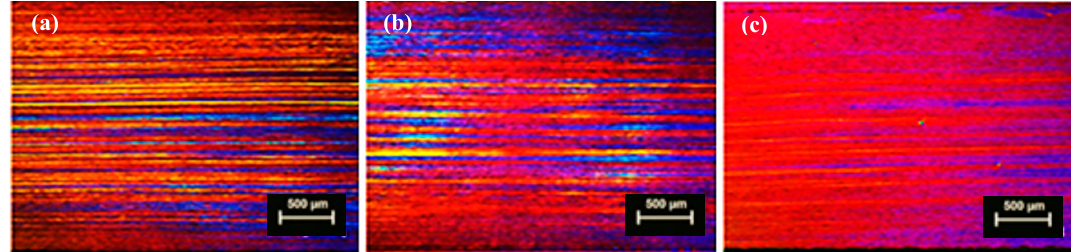
Figure 6. Micrographs of planks extruded from non-homogenized MC-DC of TT-6111 (3) billet with cold rolling and heat treatment in longitudinal direction; ( a ) annealing of as-cast planks at 360 ◦ C for 2 h; ( b ) cold rolling of annealed planks to 3 mm; ( c ) annealing of 3 mm planks at 360 ◦ C for 2 h.